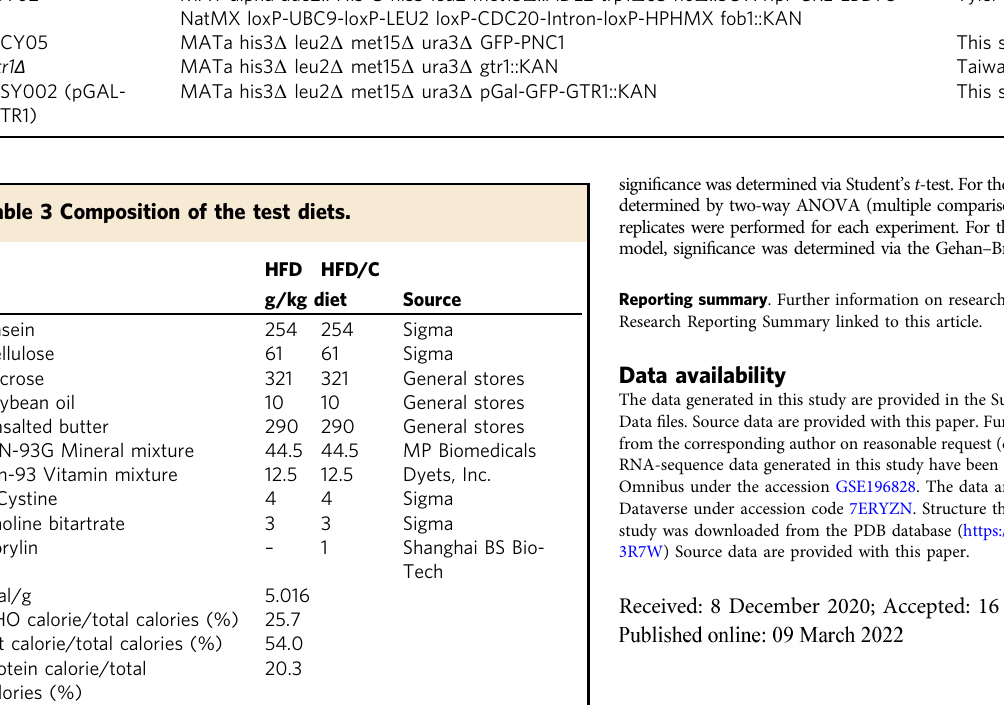
Rearing behavior . Rearing behavior was analyzed in C57BL/6J male mice fed a HFD with or without corylin for 35 weeks (75 weeks of age) using the OxyletPro System. Before the metabolic rate was monitored, the mice were individually caged for 24 h to acclimate to the system. Serum parameter analysis . The blood of C57BL/6J male mice for serum bio- chemistry was collected before sacri fi ce (102 weeks of age). The serum LDL, TG, and total cholesterol levels were measured using speci fi c reagent kits (Fortress Diagnostics, Antrim, Northern Ireland). The serum glucose and high-density lipoprotein (HDL) levels were measured using speci fi c reagent kits (Randox, Antrim UK). Insulin was measured by ELISA (Mercodia, Uppsala, Sweden). HOMA-IR was calculated as the fasting insulin level (mU/l) × blood glucose level (mmol/l)/22.5. The serum AST and CK levels were measured using a Fuji Dri- Chem 4000i analyzer (Fuji fi lm, Tokyo, Japan). Statistics and reproducibility . Graphic visualization and statistical analyses were performed by GraphPad Prism 6. All values are provided as the mean±SD. The exact p value was provided in fi gures or legend. For the MEP assay, fl uorescence microscopy, western blotting, SA- β -gal staining, rotarod test, and rearing behavior experiment,